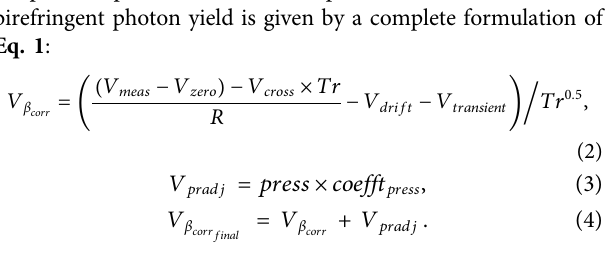
Frontiers in Remote Sensing |